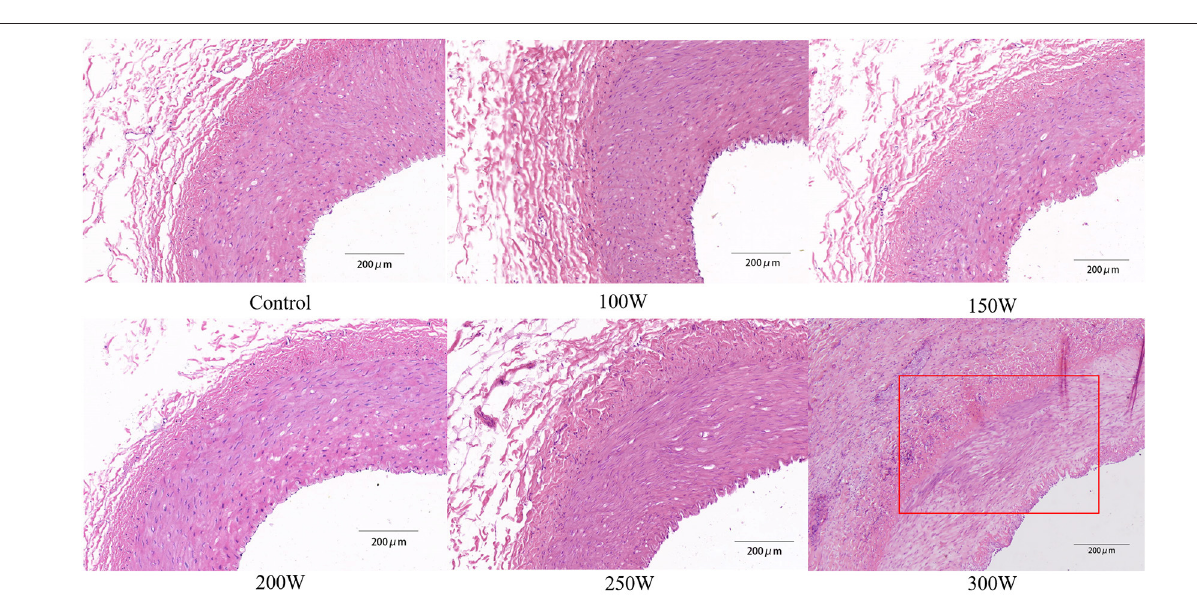
FIGURE 8 | Representative histological images of renal artery in different groups. Red rectangle exhibits renal vascular muscle cell loss with proteoglycan replacement, which was the result of the thermal effect of HIFU